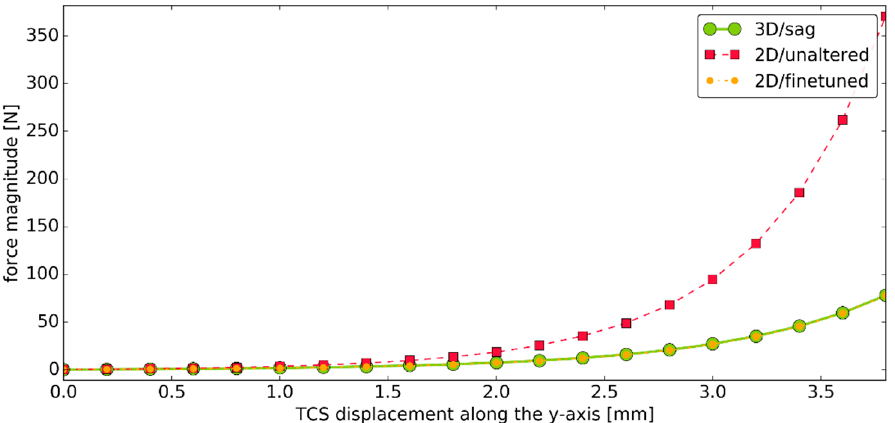
Figure 3. The graph of one of the considered displacements versus the value of the force generated by the following: a three-dimensional PTT ligament with unaltered sti ff ness parameters from the work of [37] in the sagittal plane (green), its planar counterpart with unaltered sti ff ness parameters from the work of [37] (red), and a planar counterpart with fine-tuned material parameters using the proposed custom approach